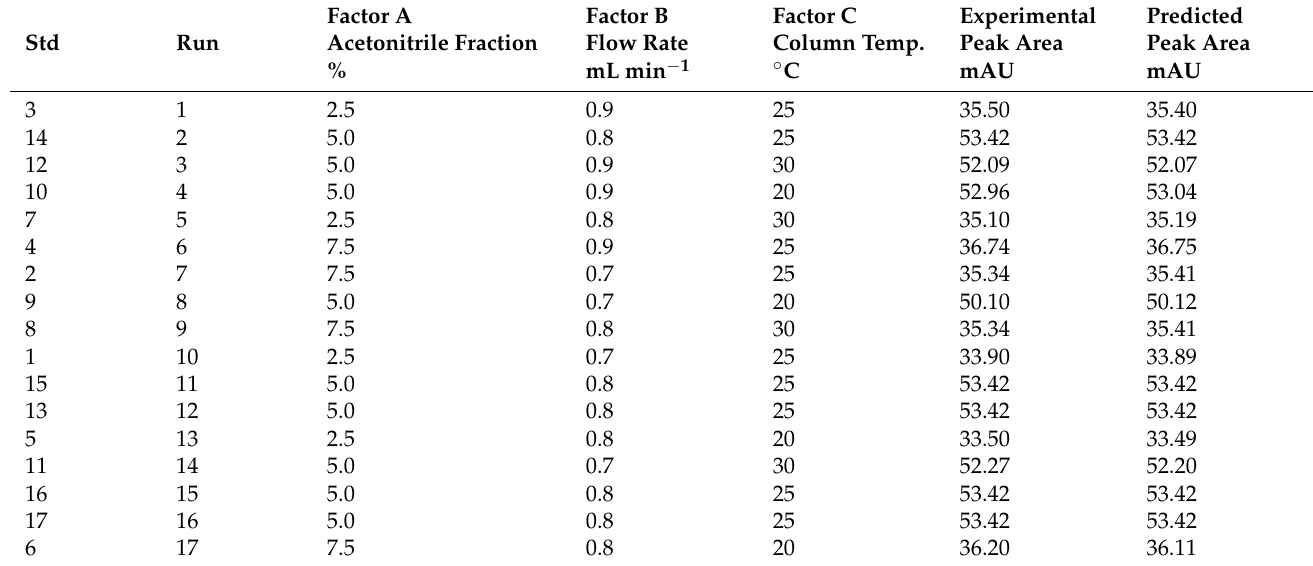
Table 2. Box–Behnken design matrix with experimental and predicted peak area.